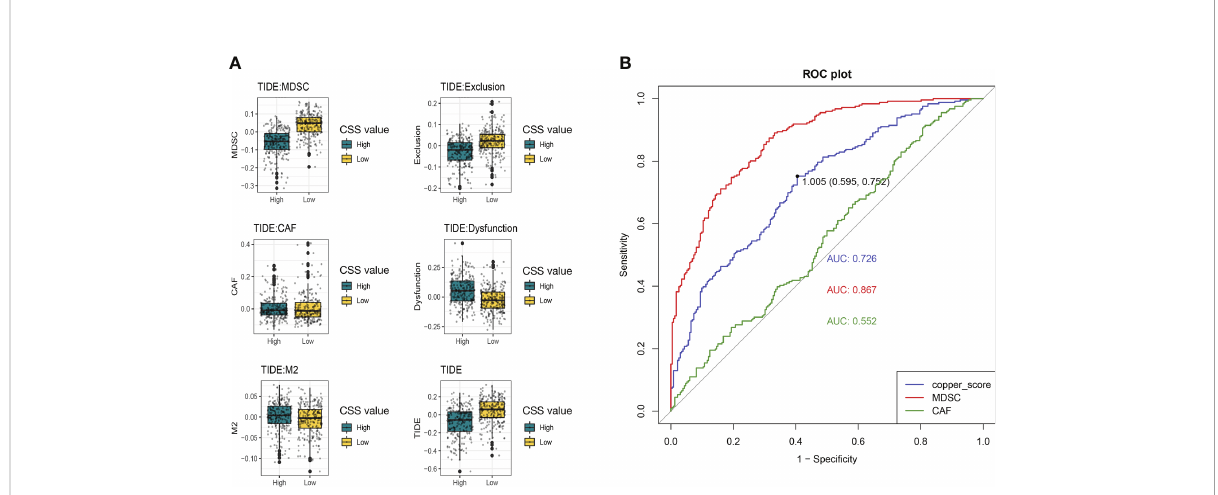
FIGURE 11 The immune response in different CSS subgroups. (A) The comparation of different forms of TIDE scores between high and low CSS subgroups. (B) ROC curves for predicting immune response. TIDE, tumor immune dysfunction and exclusion; ROC, receiver operating characteristic